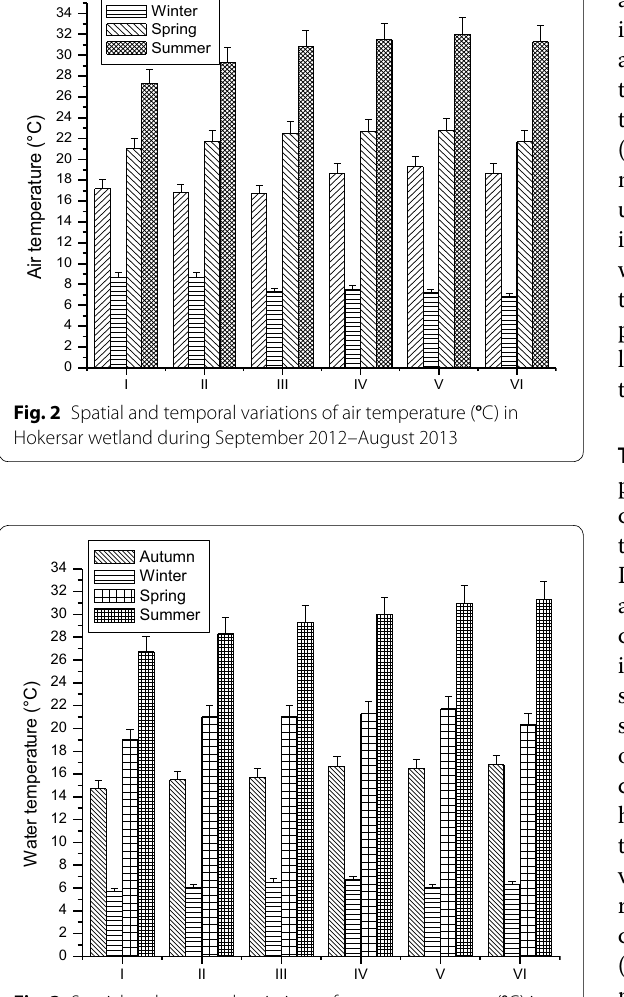
Fig. 3 Spatial and temporal variations of water temperature ( ° C) in Hokersar wetland during September 2012–August